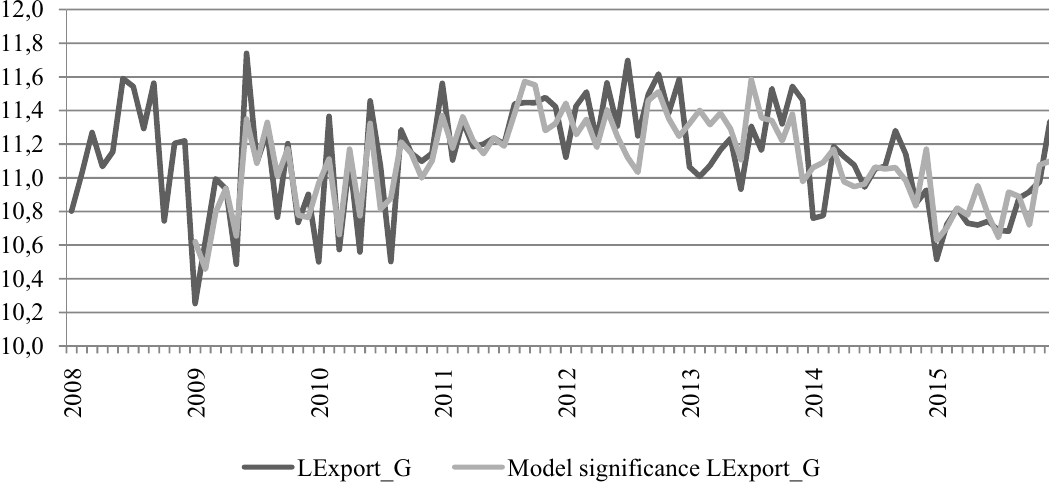
Fig. 4. Actual and estimated value for exports in Sumy region according to VAR